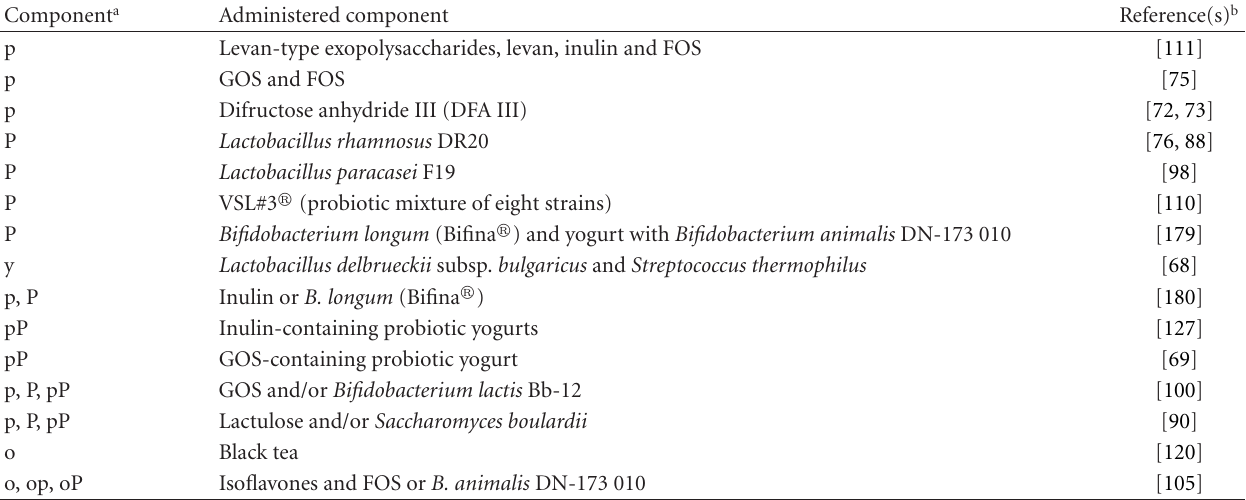
Table 3: Selection of dietary intervention studies using SDE-based community